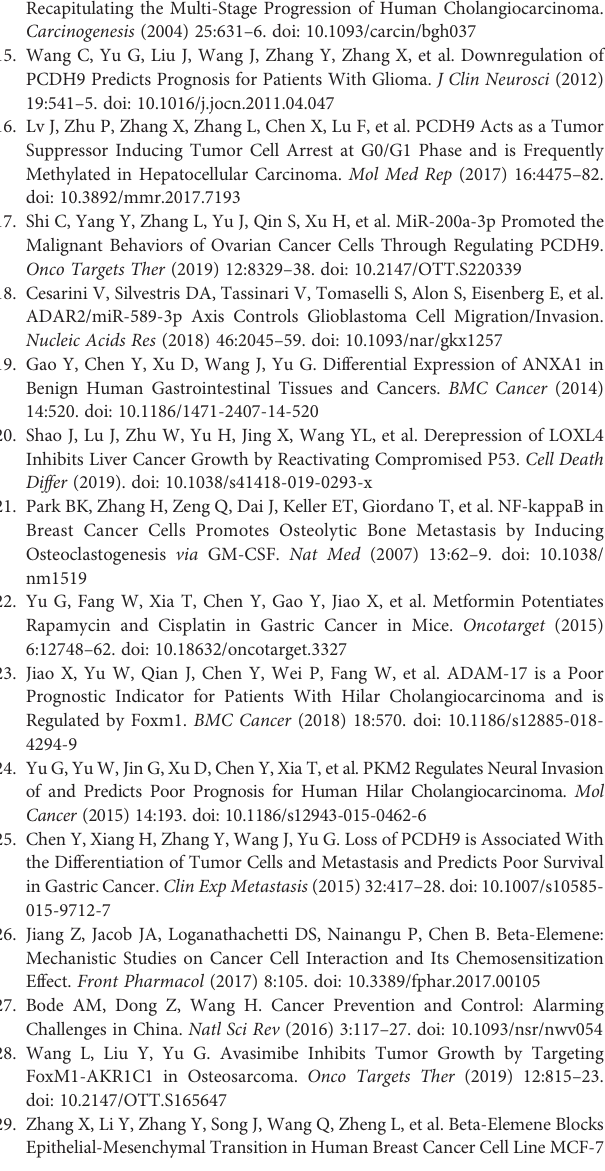
Supplementary Figure 4 | Apoptotic genetically manipulated QBC-939 or ICC-9810 cells was performed by PI/Annexin V double staining kit following b - elemene treatment at indicated concentrations and time points. * P<0.05, ***P<0.001. Supplementary Figure 5 | b -elemene inhibited cell proliferation by regulating energy metabolism-related genes. (A, B) Cluster of changed genes involved in metabolism (A) and the linear trend of selected genes at indicated time points (B) . (C) QBC-939 cells were treated with b -elemene (500 ug/ml) for 48 hours and PCK2 mRNA levels were measured using quantitative RT-PCR. Supplementary Figure 6 | After TAA induction, rats were treated with or without b -elemene (500 ug/ml) for 1 week and then liver was obtained for quantitative RT-PCR using primers against rat PCDH9 (A) . **P<0.01. PCDH9 expression patterns in human liver (B) and bile ducts (C) were shown by IHC. Scale bar, 200 m